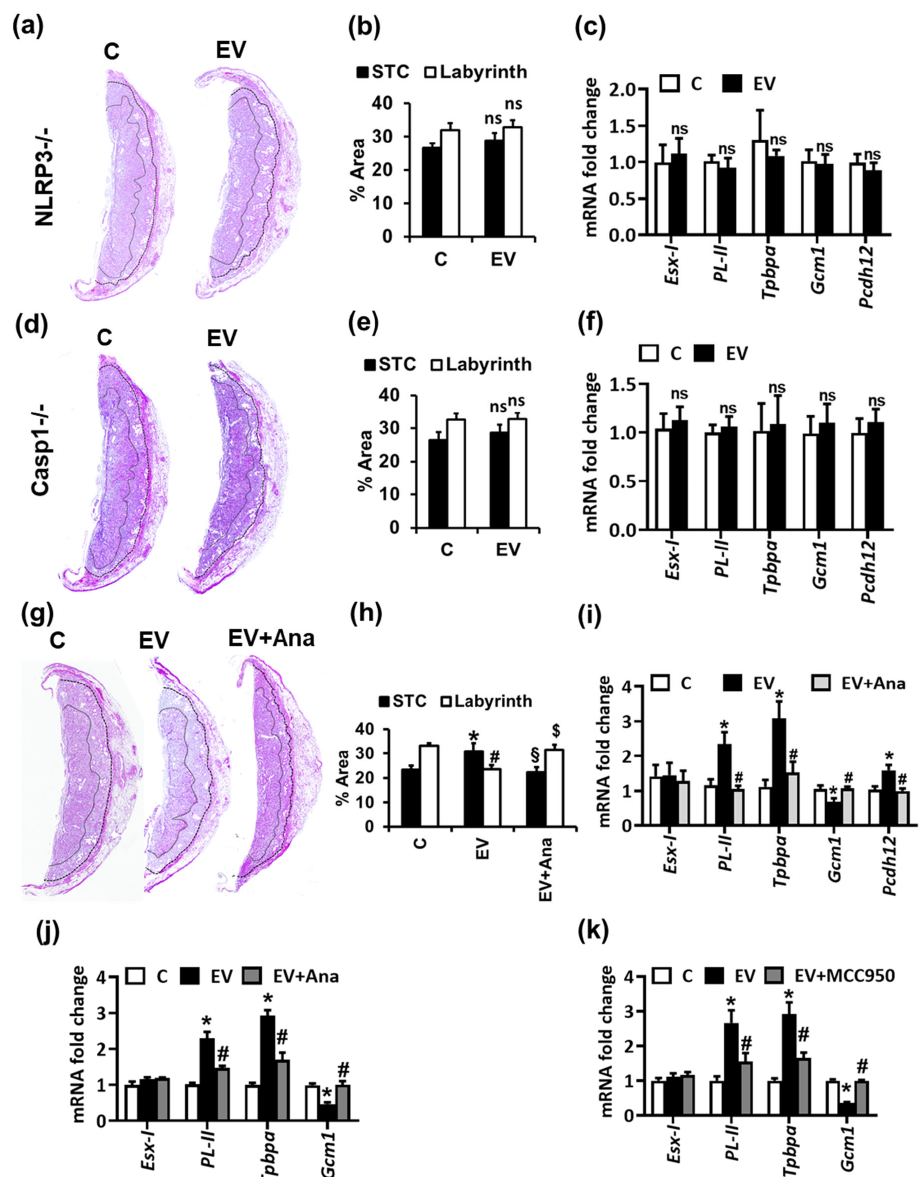
Figure 3. EVs impair trophoblast differentiation in an inflammasome-dependent manner. ( a – f ) NLRP3 or Caspase-1 knockout prevents EV induced trophoblast alterations. Hematoxylin and eosin (H&E)-stained placentae (( a , d ), representative images; ( b , e ), bar-graph summarizing results) show that NLRP3 − / − ( a , b ) or Casp-1 − / − ( d , e ) mice are protected from EV-induced morphological alterations in junctional and labyrinth zone. qPCR analysis for trophoblast differentiation markers ( c , f ) in NLRP3 − / − or Casp-1 − / − mouse placenta showing no change in differentiation markers ( Tpbpa , PL-II , Gcm-1 ) or glycogen-rich cell marker ( Pcdh12 ) upon EV treatment. ns: non-significant; ANOVA ( b , c , e , f ). ( g – k ) Inflammasome inhibition prevents EV-induced trophoblast alterations. In vivo intervention with the IL-1R antagonist anakinra in EV injected pregnant mice prevents morphological alterations (H&E staining; ( g ), representative images; ( h ), bar graph summa- rizing results) of labyrinth zone (LZ) and junctional zone (JZ) in placenta from EV-injected mothers. * p < 0.05 (JZ, relative to C), # p < 0.05 (LZ relative to C), § p < 0.05 (JZ, relative to EV), $ p < 0.05 (LZ relative to EV); ANOVA ( h ). ( i – k ) qPCR analysis for trophoblast differentiation and glycogen-rich cell markers in mouse placenta ( i ) or mouse trophoblast stem cells ( j , k ) showing that inflammasome inhibition using anakinra ( i , j ) or the NLRP3 inhibitor MCC950 ( k ) prevents